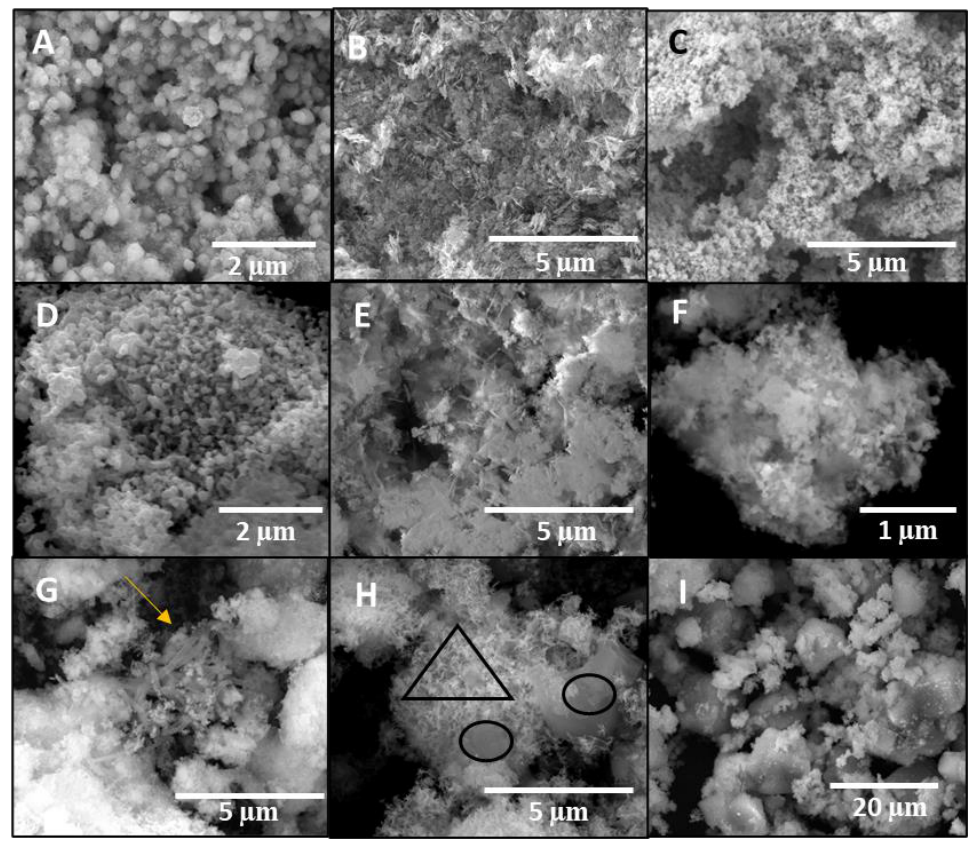
Figure 5. SEM images of the catalysts: ( A ) Cu nanoparticles; ( B ) ZnO nanoparticles; ( C ) ZnO nanoparti- cles with PVP; ( D ) CuO/ZnO bimetallic nanoparticles; ( E ) Cu/ZnO bimetallic nanoparticles with PVP; ( F ) Cu/ZnO bimetallic nanoparticles; ( G ) Cu/ZnO/polypyrrole nanotubes; ( H ) Cu/ZnO/activated carbon; ( I ) Cu/ZnO/zeolite. The arrow indicates the polypyrrole nanotubes, the triangle indicates the bimetallic nanoparticles, and the circumferences indicate the activated